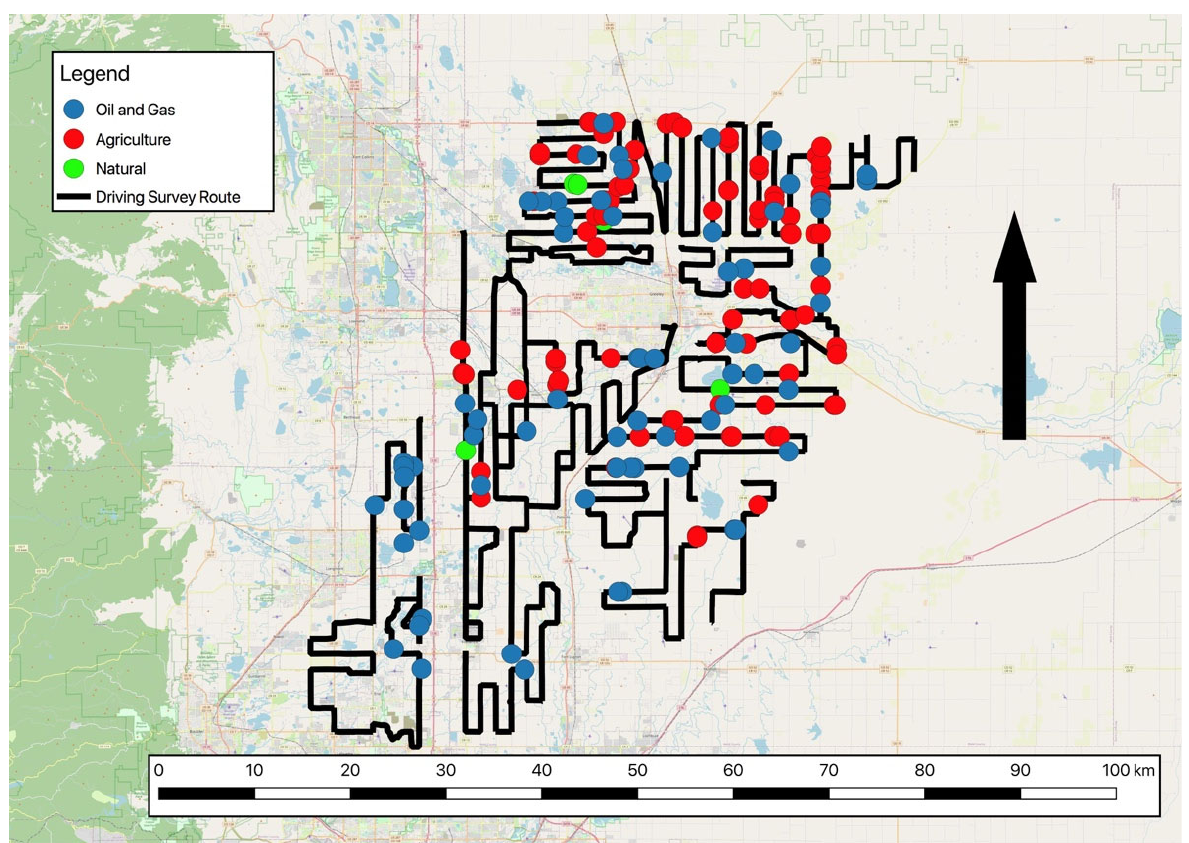
Figure 1. Driving survey route in the Denver–Julesburg basin and locations of natural, oil and gas and agricultural sources detected. The arrow shows North.